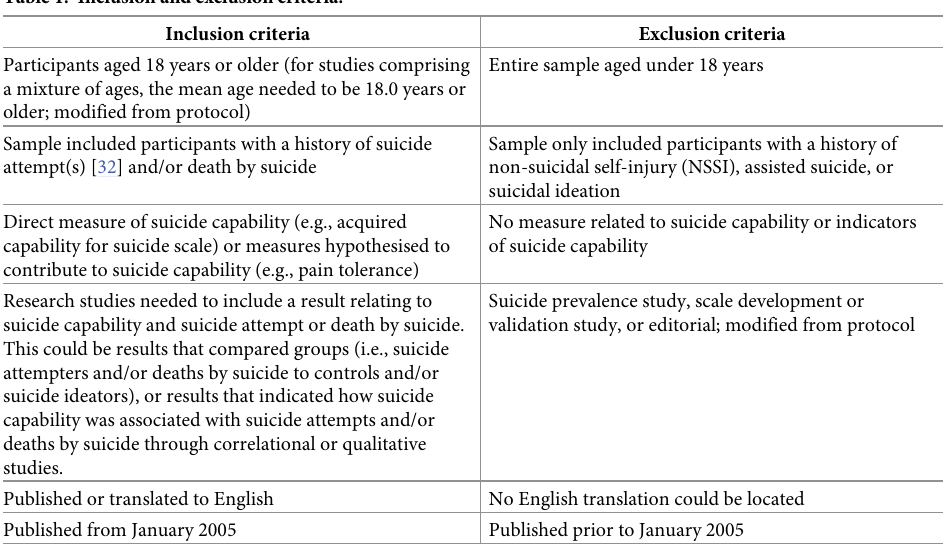
Table 1. Inclusion and exclusion